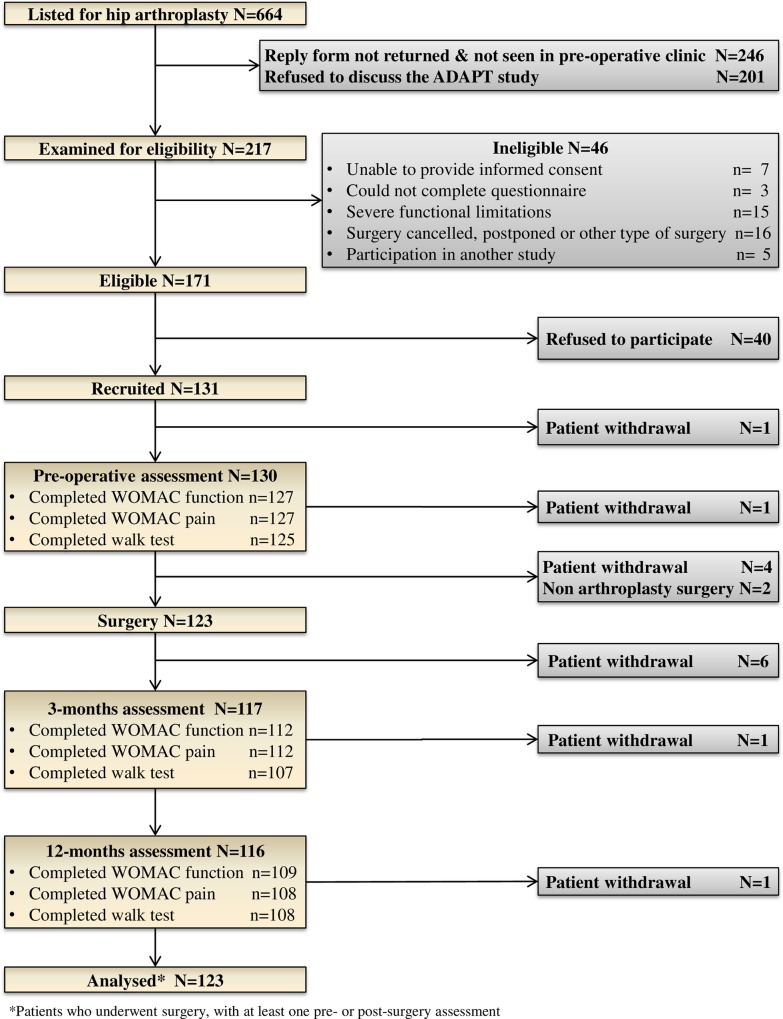
Flow diagram of recruitment and participation.